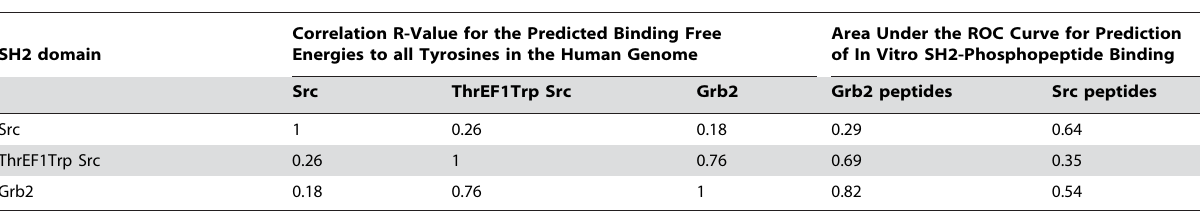
Table 2. FoldX prediction of the change in specificity of the Src SH2 domain ThrEF1Trp mutant.